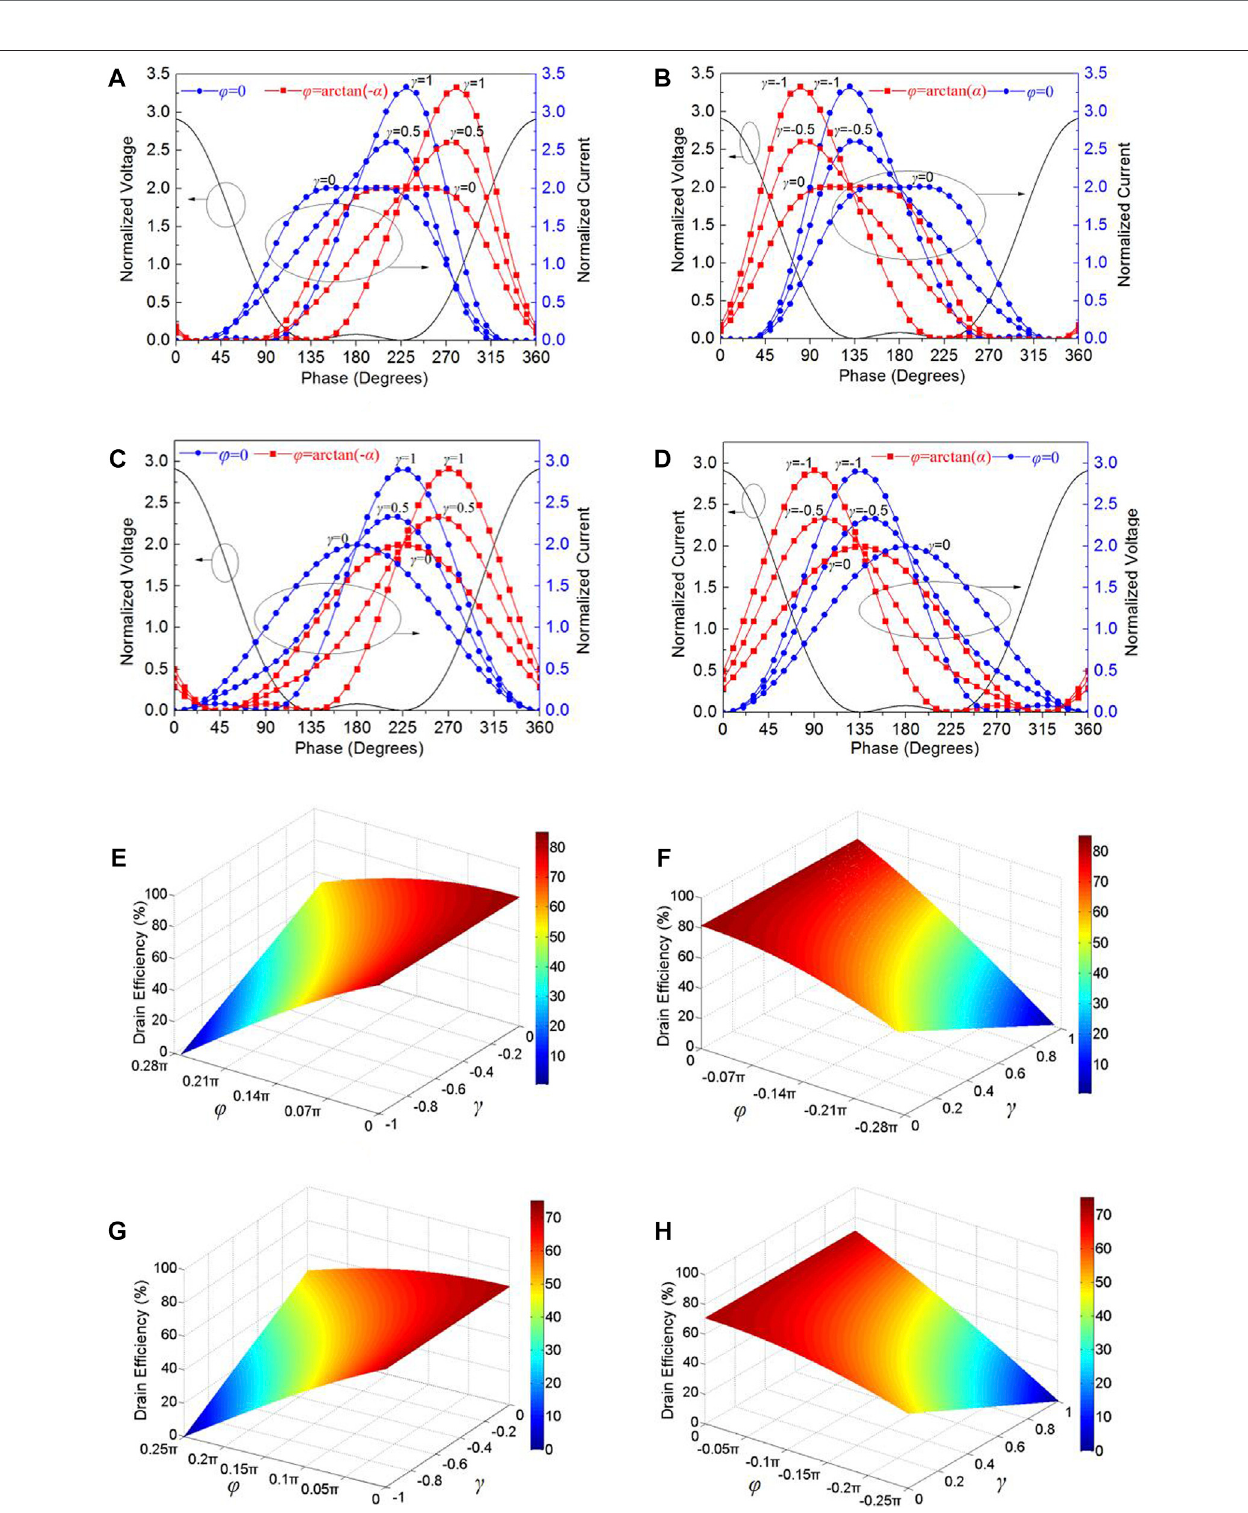
FIGURE 1 | Theoretical voltage and current waveforms and drain ef fi ciency. (A – D) Theoretical voltage and current waveforms when φ (cid:2) arctan(- α ), φ (cid:2) 0 , φ (cid:2) arctan( α ). (A) α (cid:2) 43/37, β (cid:2) 6/37, and φ ∈ [arctan(- α ), 0]. (B) α (cid:2) 43/37, β (cid:2) 6/37, and φ ∈ [0, arctan( α )]. (C) α (cid:2) 1, β (cid:2) 0, and φ ∈ [arctan(- α ), 0]. (D) α (cid:2) 1, β (cid:2) 0, and φ ∈ [0, arctan( α )]. (E – H) Theoretical drain ef fi ciency with respect to c and φ . (E) α (cid:2) 43/37, β (cid:2) 6/37, and φ ≥ 0. (F) α (cid:2) 43/37, β (cid:2) 6/37, and φ ≤ 0. (G) α (cid:2) 1, β (cid:2) 0, and φ ≥ 0. (H) α (cid:2) 1, β (cid:2) 0, and φ ≤ 0.